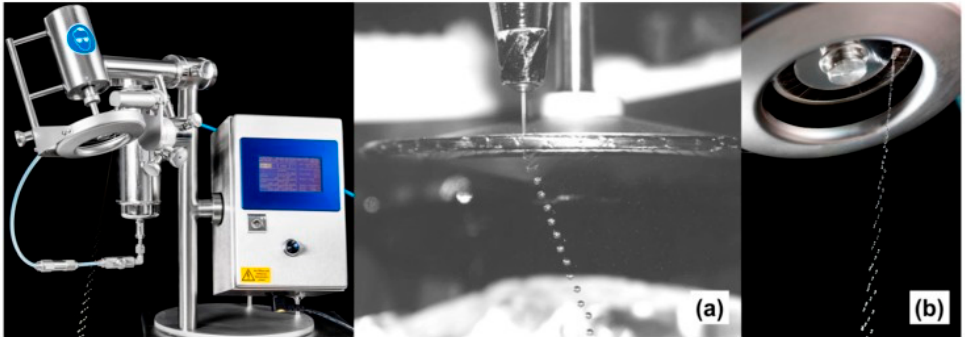
Figure 3. Image showing the tabletop JetCutter machine on the left and different Jet cutting tools producing a single stream of droplets: single ( a ) and multi-stream of droplets ( b ) [37].